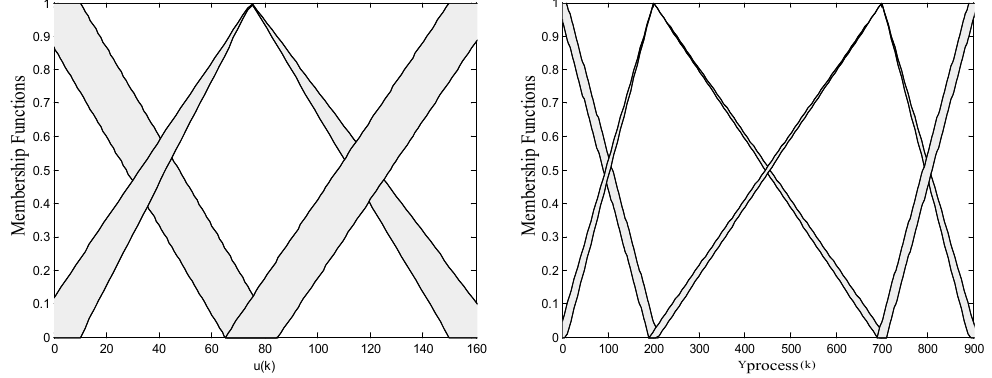
Figure 9. The block diagram of the cyber-physical system (CPS).